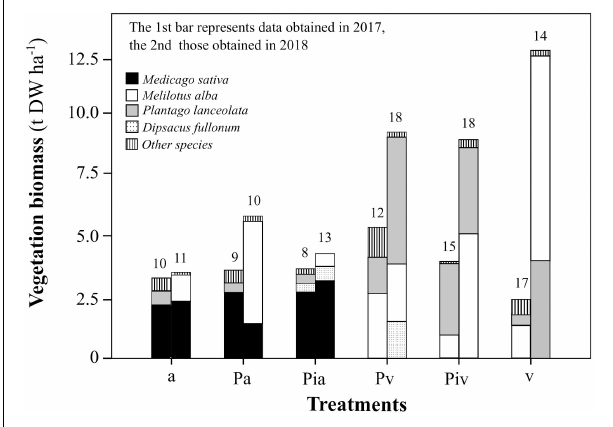
( Figure 4B ), and bacterial functional diversity ( Figures 4C,D ) were lower than in July 2018. Soils in the poplar/alfalfa intercropping system (Pa treatment) showed significantly lower substrate-consumption activity (SCA) compared to the plots with poplar trees and spontaneous vegetation (Pv and Piv